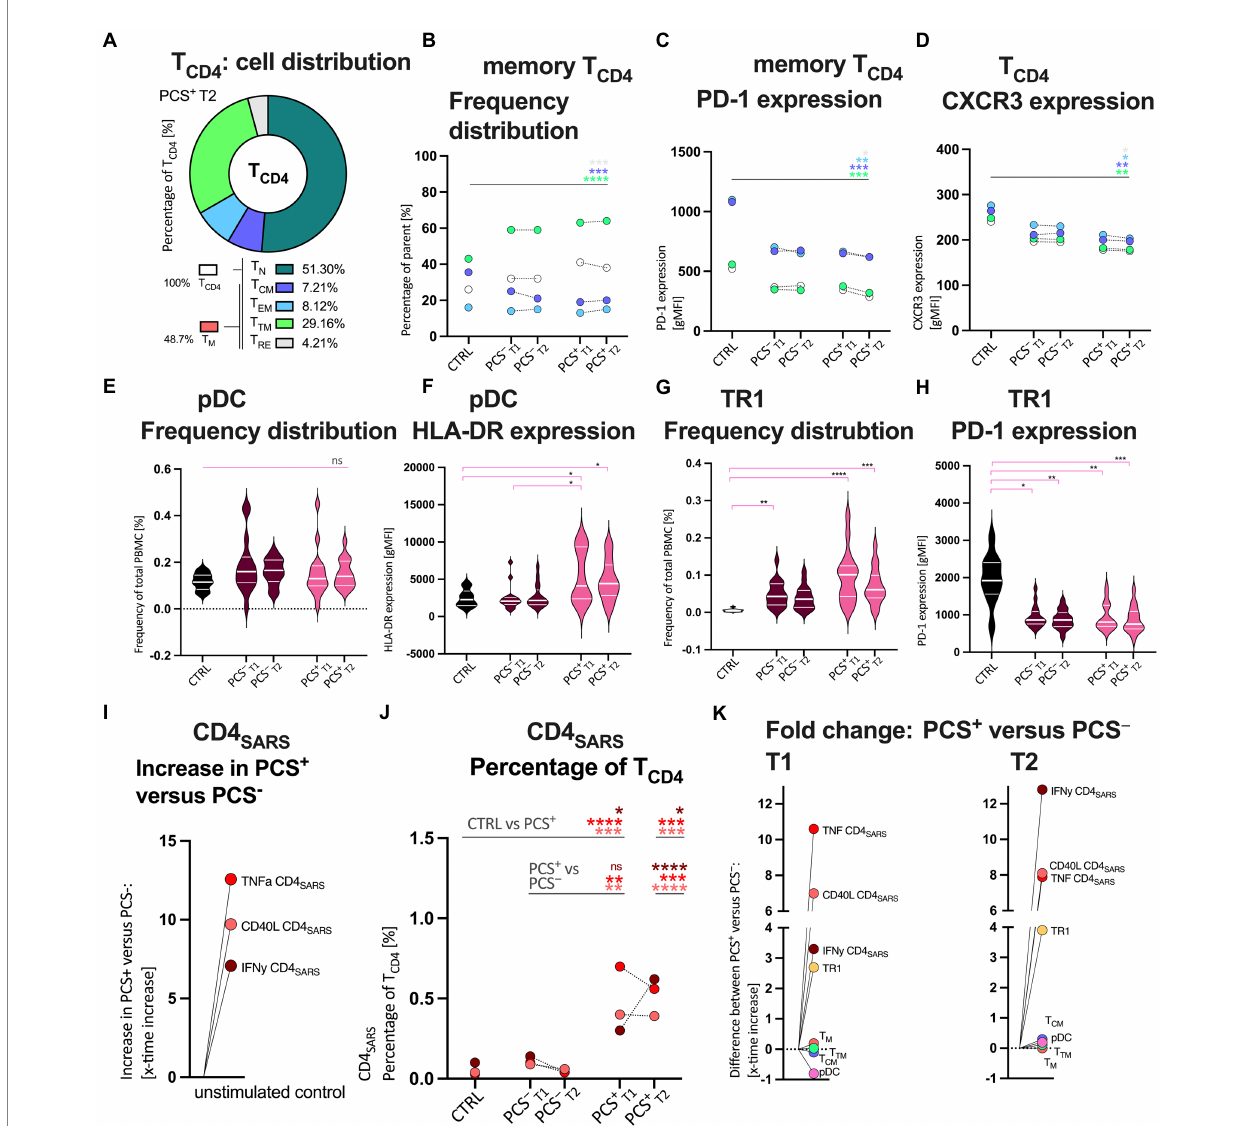
FIGURE 2 Quantitative and qualitative attributes of CD4 + T-cells (T CD4 ), Bystander cells, and protein-S1 (PS1)-stimulated SARS-CoV-2 specific CD4 + (CD4 SARS ) in CTRL, PCS − , and PCS + at T1 and T2, respectively. (A) Exemplary distribution of all T CD4 in PCS + . Percentage of T CD4 (%). Color legends also apply to B–D . (B) Median frequency distribution of T CD4 and its memory subpopulations by cohort. Percentage of parent (%). (C) T CD4 and its memory subpopulations: Median expression of PD-1 (gMFI); (D) T CD4 and its memory subpopulations: Median expression of CXCR3 (gMFI). (E) Plasmacytoid dendritic cells (pDC): Frequency distribution (%). (F) pDC: Expression of human leukocyte antigen DR (HLA-DR; gMFI); (G) Type 1 regulatory T-cells (TR1): Frequency distribution (%) H TR1: Expression of PD-1 (gMFI). Distribution of distinct CD4 SARS in I unstimulated assay controls and J after PS1-stimulation in all cohorts (%). ( K ; i) Increased frequencies of PS1-stimulated CD4 SARS , CD8 SARS (see Supplementary Figure S6), and TR1 in PCS + versus PCS − at T1 and T2, respectively.